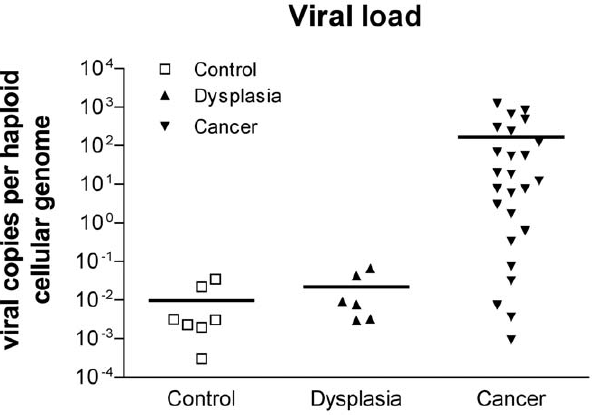
Figure 1. Viral load. Viral loads in CTR, DYS and SCC cervical tissues are expressed as E6 copies/ b -globin copies/cell.